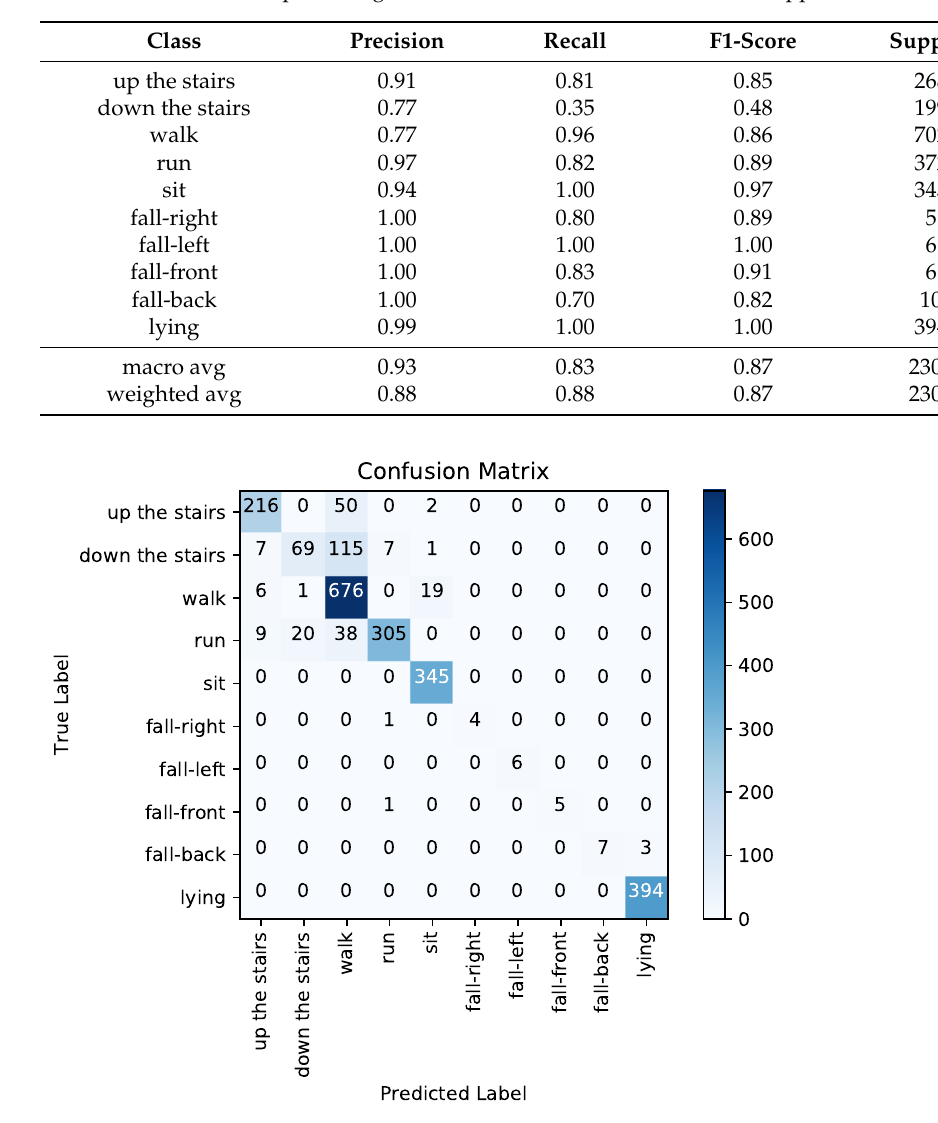
Table 2. Classification report using the automatic feature extraction based approach.